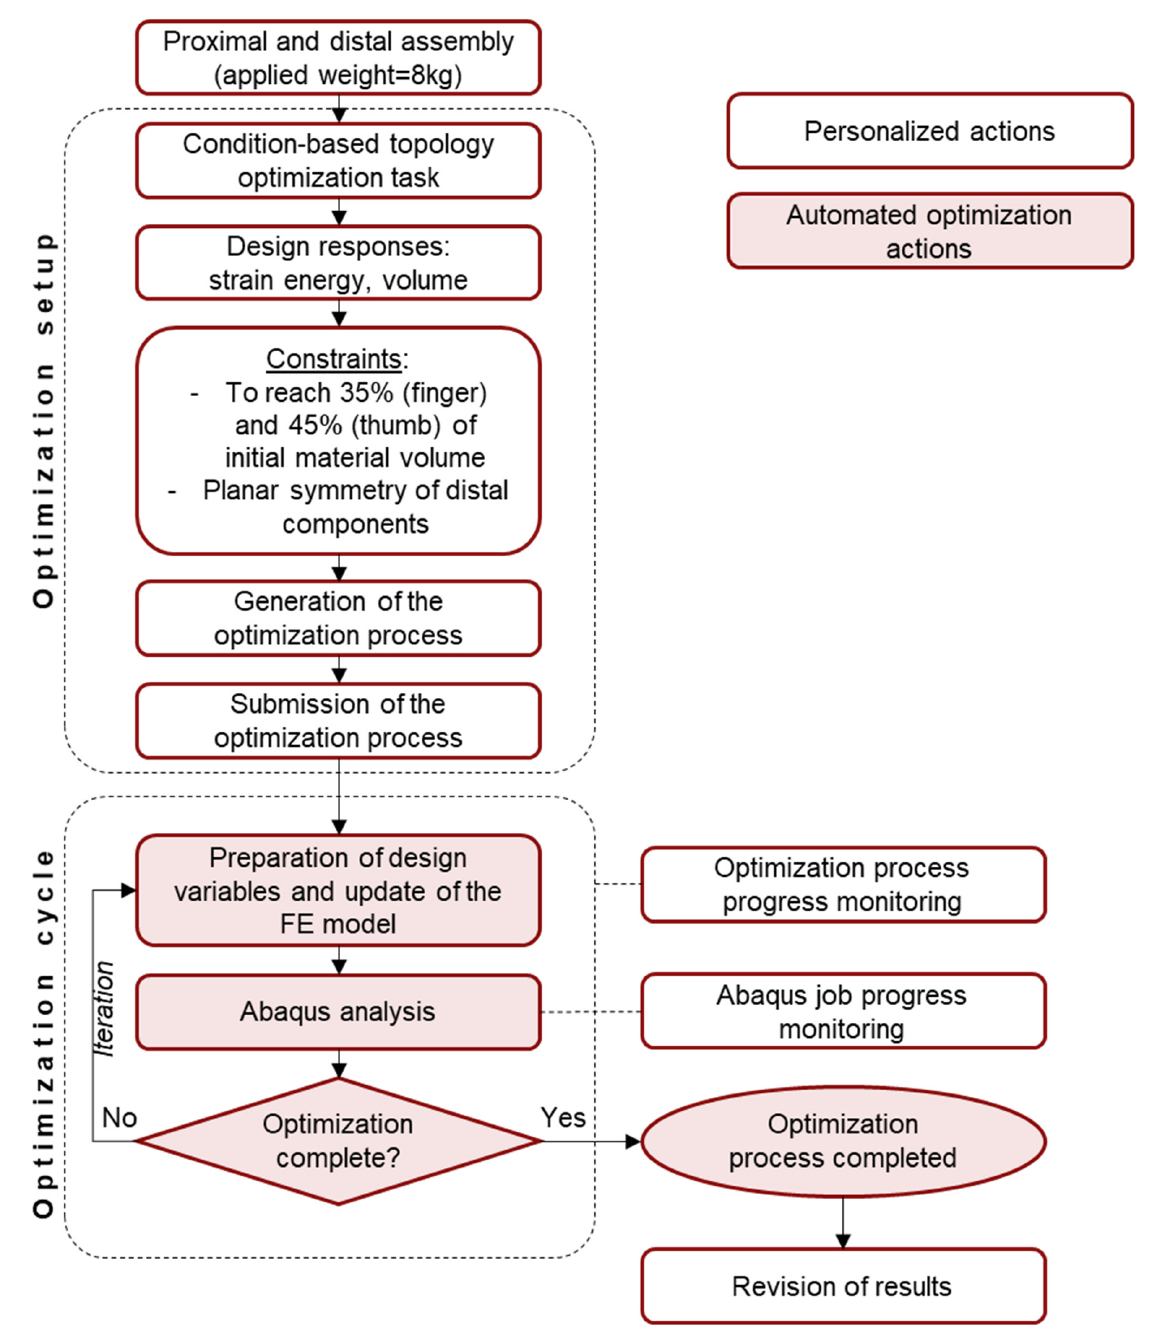
Figure 4. Optimization process adopted for the obsolete finger and thumb. Personalized actions are reported in white boxes. Automated optimization actions are reported in pink.